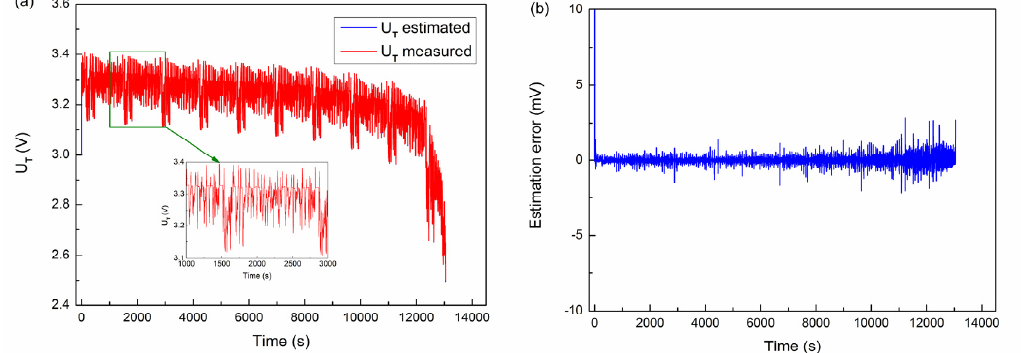
Figure 18. Validation of the identification method in the FUDS test at 30 °C: